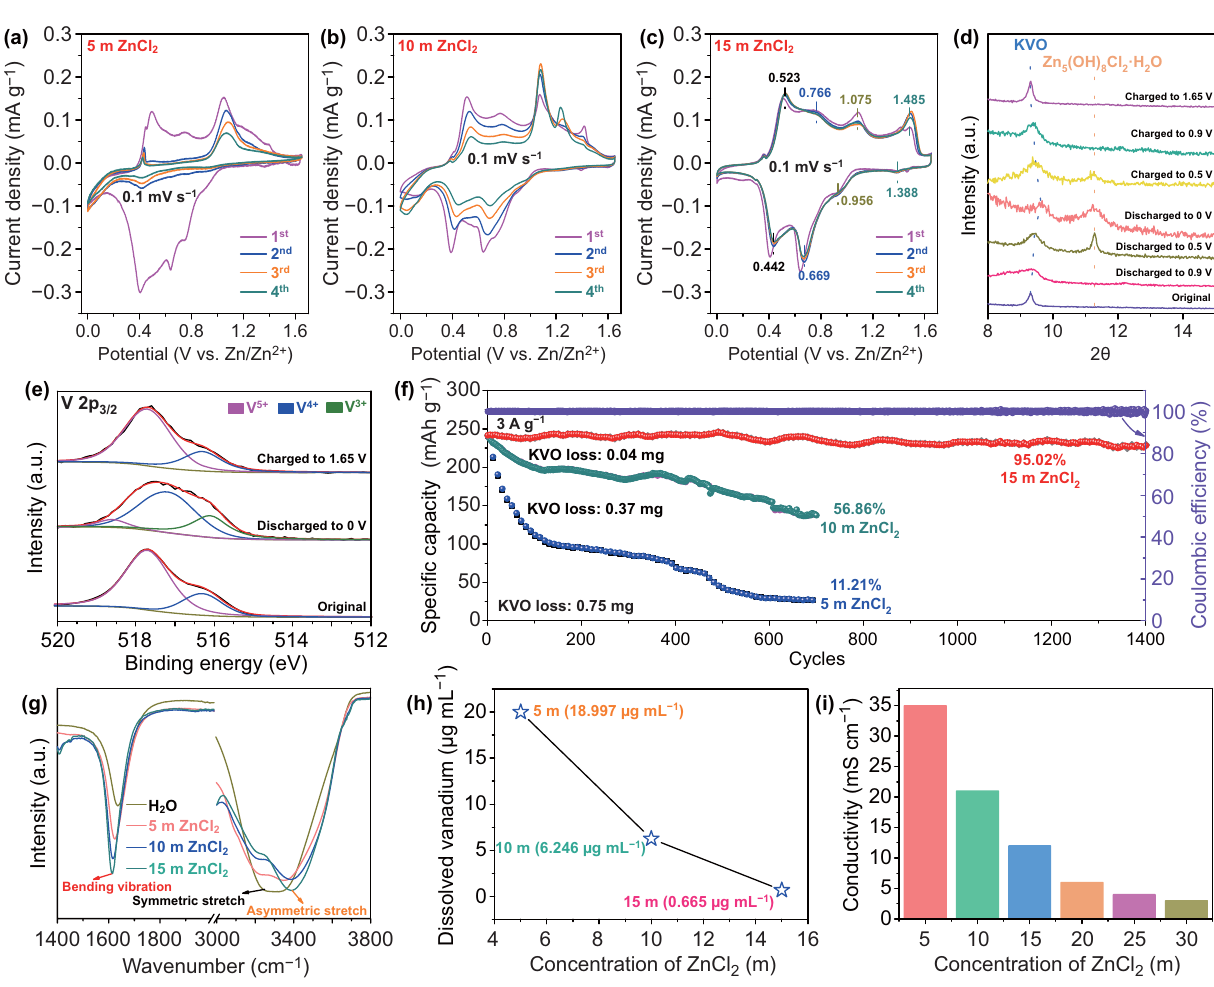
Fig. 3 a–c CV curves of KVO measured at a scan rate of 0.1 mV s −1 in 5 m ZnCl 2 , 10 m ZnCl 2 , and 15 m ZnCl 2 electrolyte, respectively. d XRD patterns of KVO and e high-resolution XPS spectra of V 2p at different cell states. f Cycle stability comparison in 5, 10, and 15 m ZnCl 2 electrolytes at 3 A g −1 . g FT-IR spectra of different electrolytes. h Content of dissolved vanadium in different electrolytes after KVO cycling. i Ionic conductivity values for the ZnCl 2 electrolytes with different